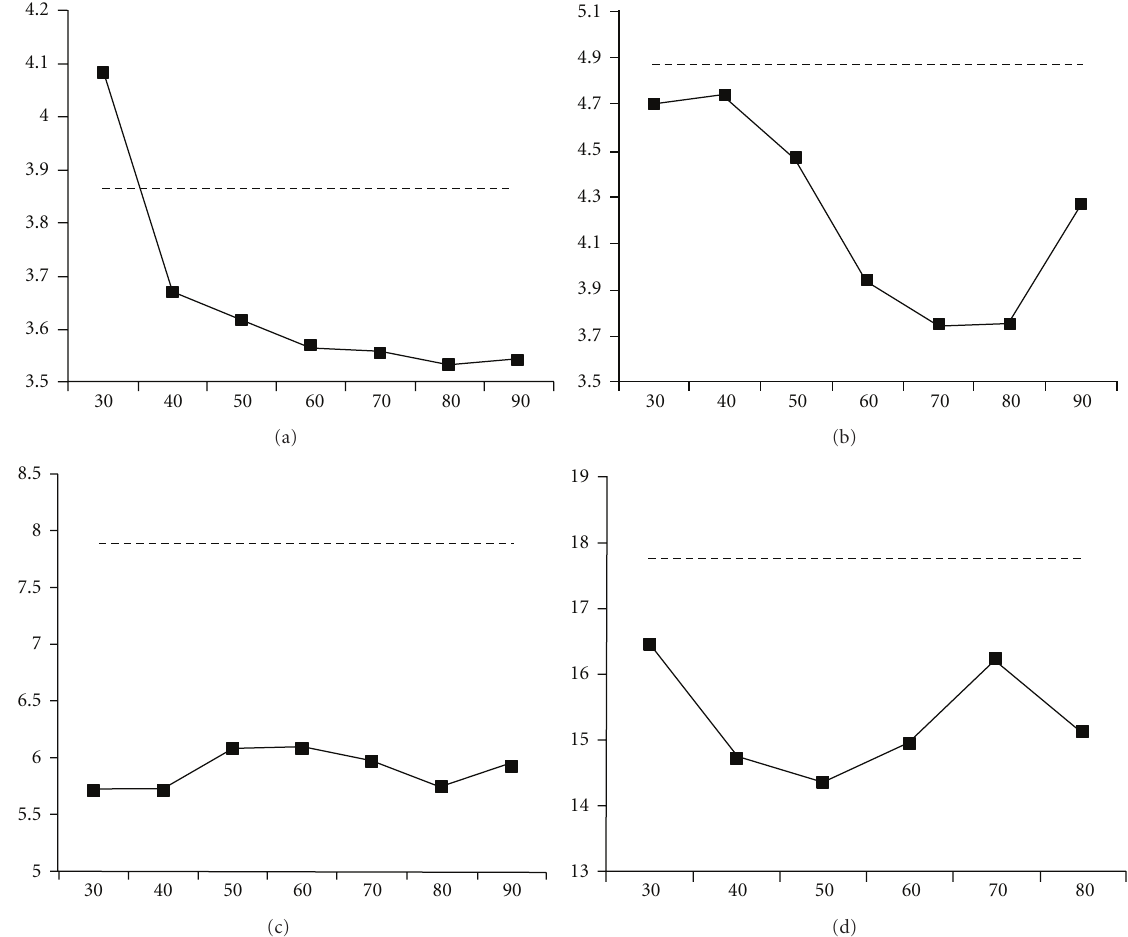
Figure 13: Comparison of RMSE by using proposed method (straight line) and standard fuzzy model (dotted line): (a) Housing dataset with c = 4, (b) body fat dataset with c = 5, (c) Parkinson’s dataset with c = 3, and (d) computer dataset with c = 3.